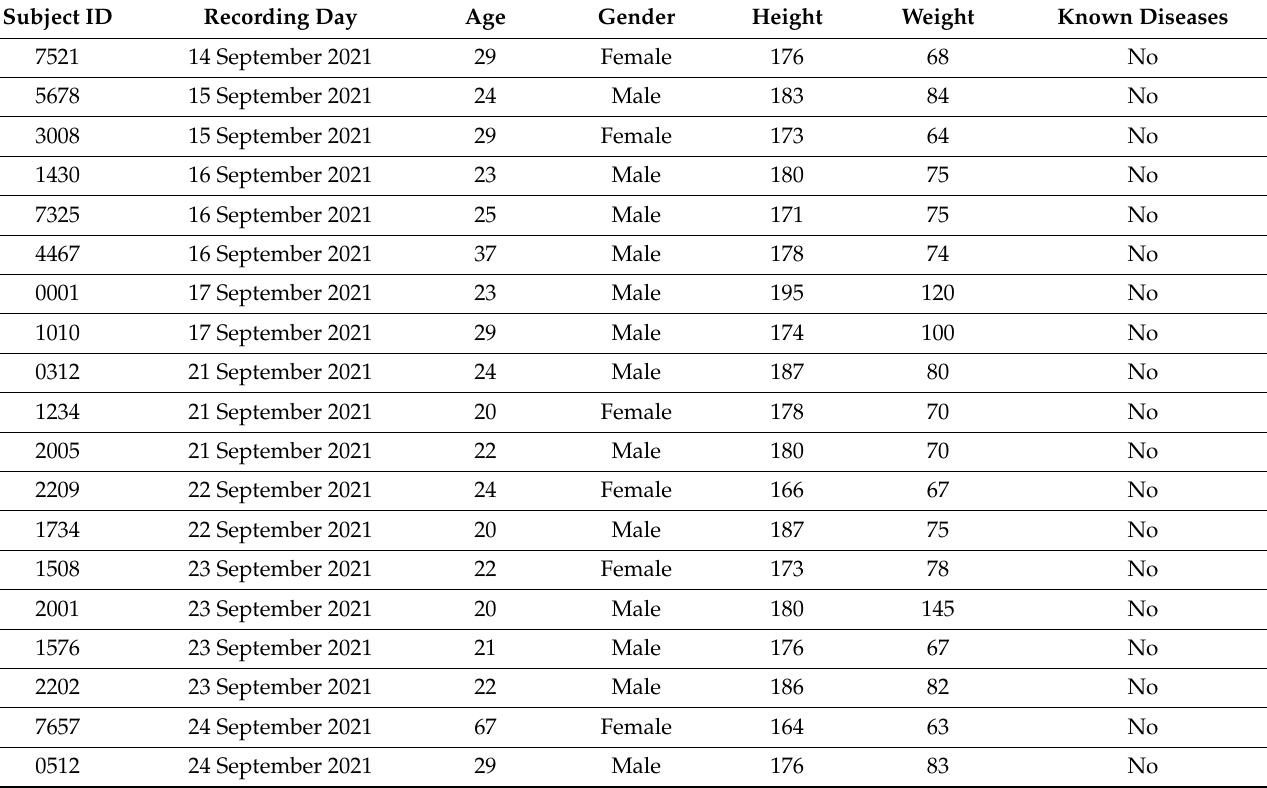
Table A1. Metadata of the 19 test